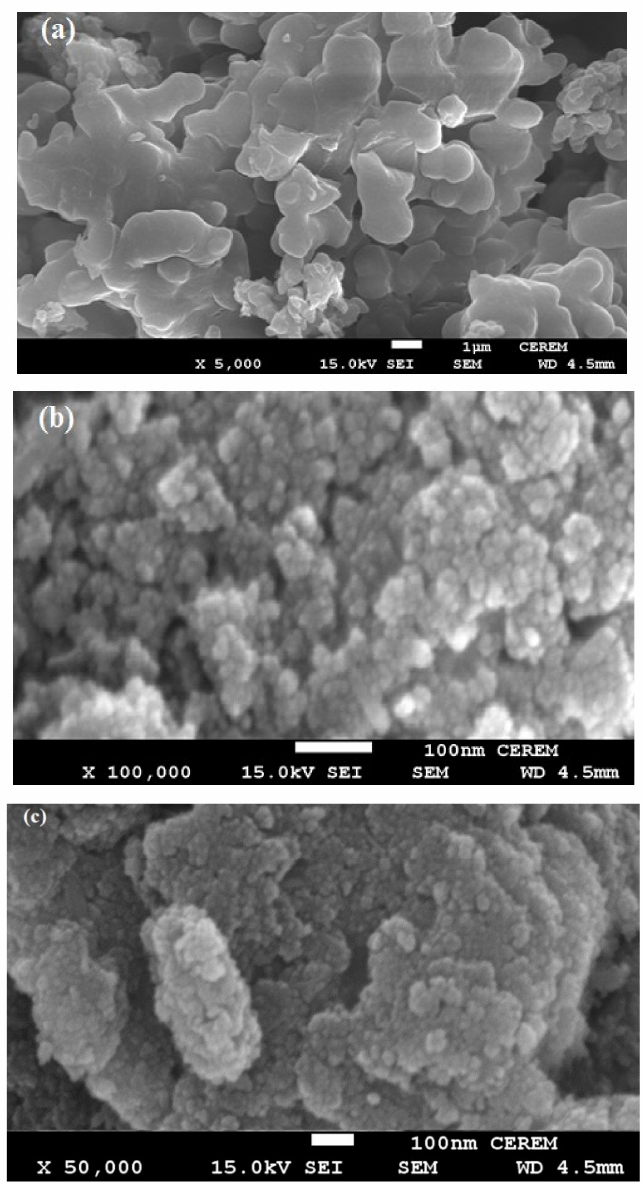
Figure 4. SEM micrographs of ( a ) QVP / AAm; ( b ) QVP / AAm-Fe 3 O 4 ; ( c ) Fe 3 O 4 -QVP /